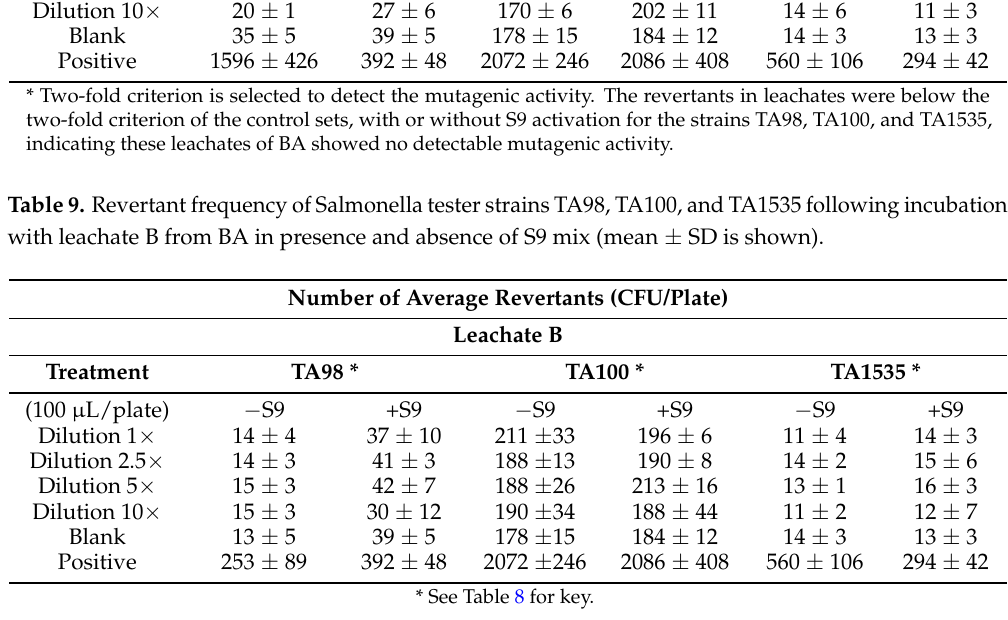
Table 10. Revertant frequency of Salmonella tester strains TA98, TA100, and TA1535 following incubation with leachate C from BA in presence and absence of S9 mix (mean ± SD is